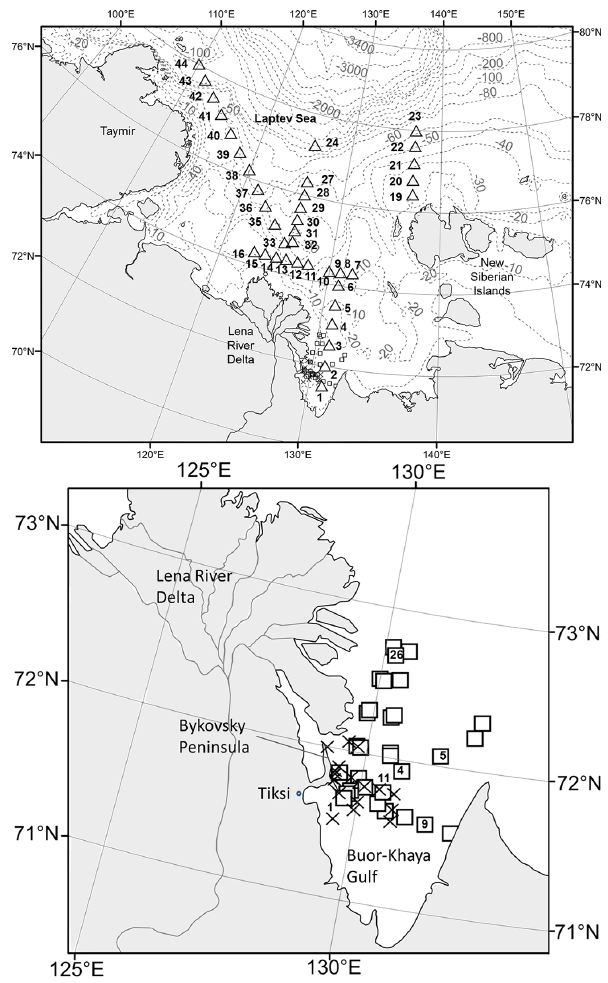
Figure 1. (a) The Southern Laptev Sea, Arctic Siberia (Russian Federation). Stations of the LENA2008 and the LENA2010 ship ex- peditions (August 2008 and August 2010) in the Buor-Khaya Gulf are displayed as small symbols of crosses and squares. Stations of the TRANSDRIFT-XVII ship expedition (from 9 to 20 September 2010) from the inner- to the outer-shelf waters are displayed as tri- angles. (b) The overview on the Lena River delta and the Buor- Khaya Gulf area shows the Lena River branches and the Bykovsky Peninsula sheltering the Tiksi Bay. Stations of the LENA2008 ship expedition southeast of the Lena River delta (from 9 to 14 August 2008) are displayed as crosses. Stations of the LENA2010 ship ex- pedition in the Buor-Khaya Gulf (from 29 July to 7 August 2010) are displayed as